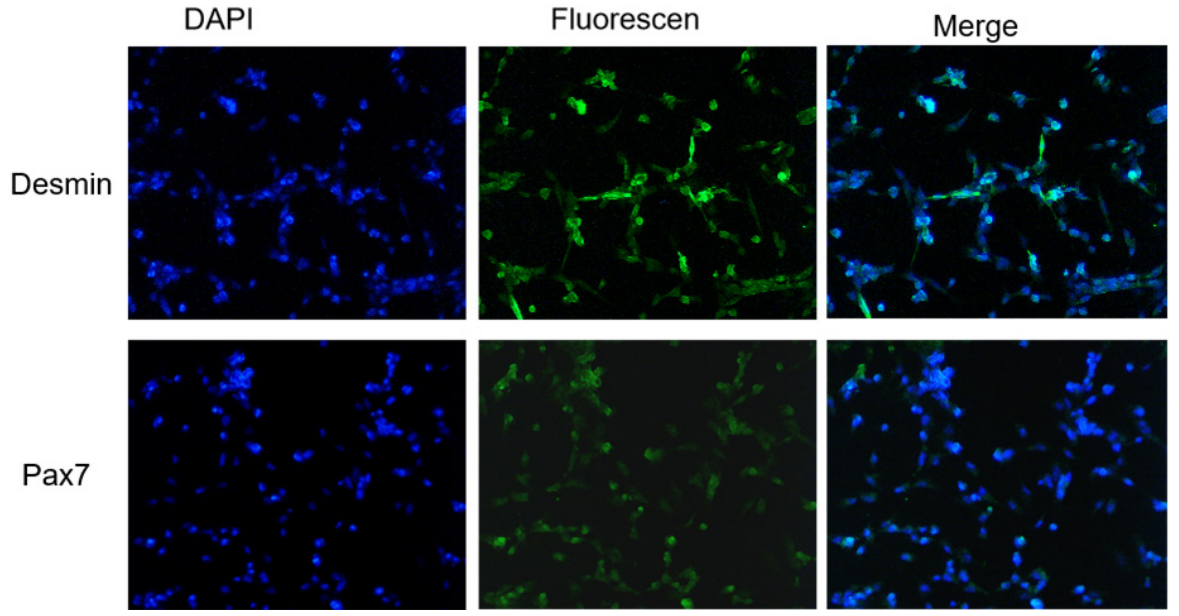
Figure 2. Identification of goose skeletal muscle satellite cells. Desmin and Pax7 were detected with Immunofluorescence; 4',6-diamidino-2-phe - nylindole (DAPI) was used to stain the nuclei of goose skeletal muscle cells (×200).